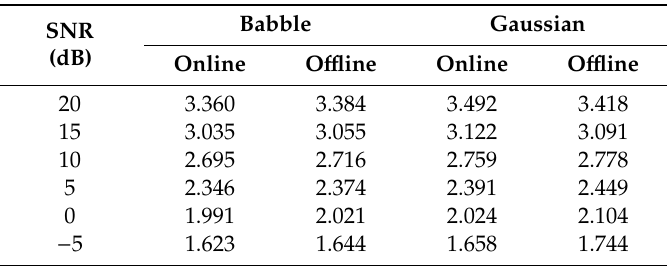
Table 2. The comparison of PESQ scores for the online and o ffl ine implementations of the proposed method under babble and Gaussian noise